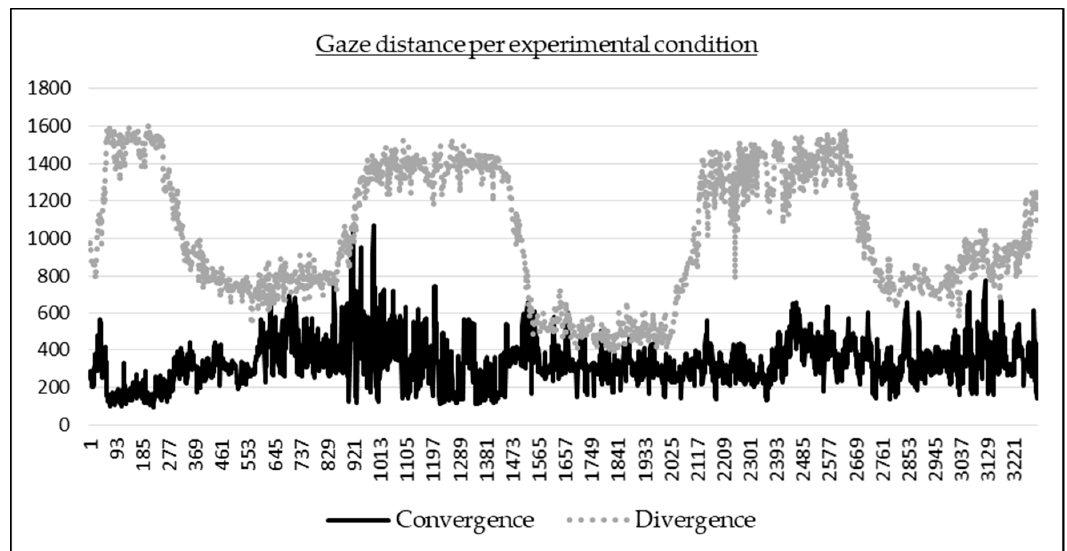
Figure 5. Average gaze distances within dyads in each experimental condition. The sinusoidal trend in the Divergence condition is consistent with the fact that the blue and the red circles alternatively moved closer to or farther from each other overtime.